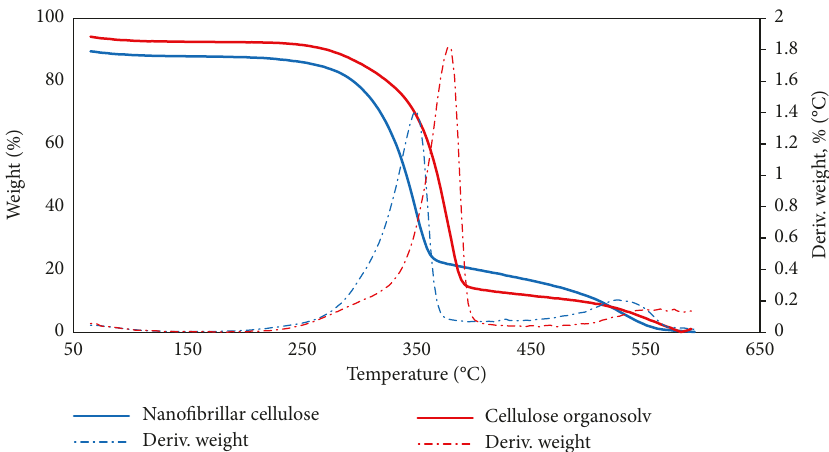
Figure 5: TG curves of organosolv cellulose and nanofibrillar